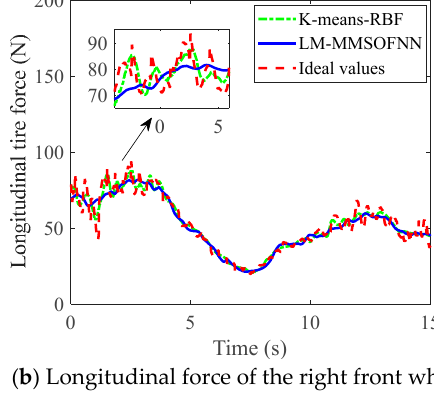
( b ) Longitudinal force of the right front wheel